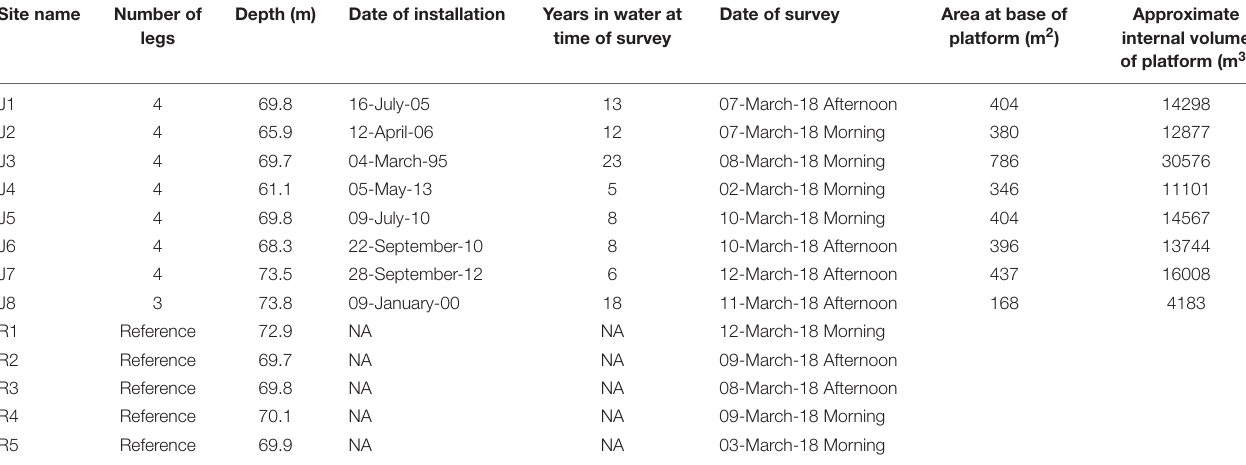
TABLE 1 | Survey site, number of legs, depth, date of installation, and time in water when surveyed. Site name